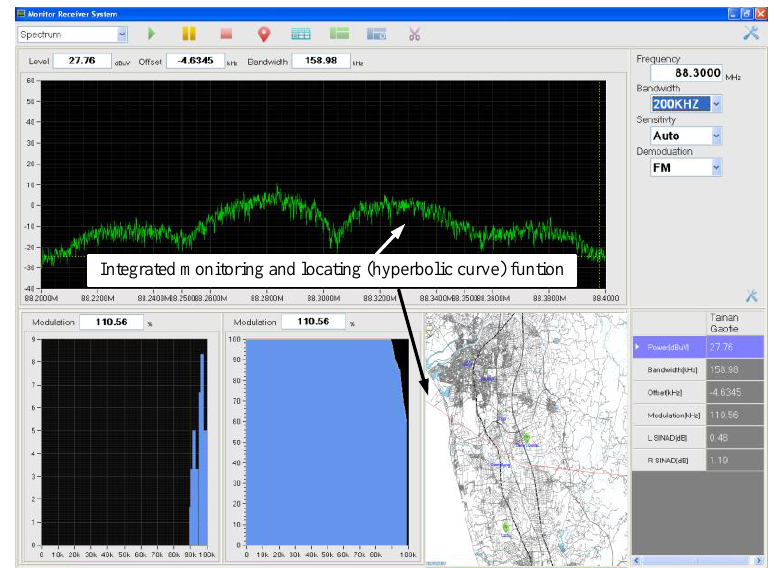
Figure 4. The proposed user interface on integrating the monitoring power spectrum density and locating position by indicating hyperbolic